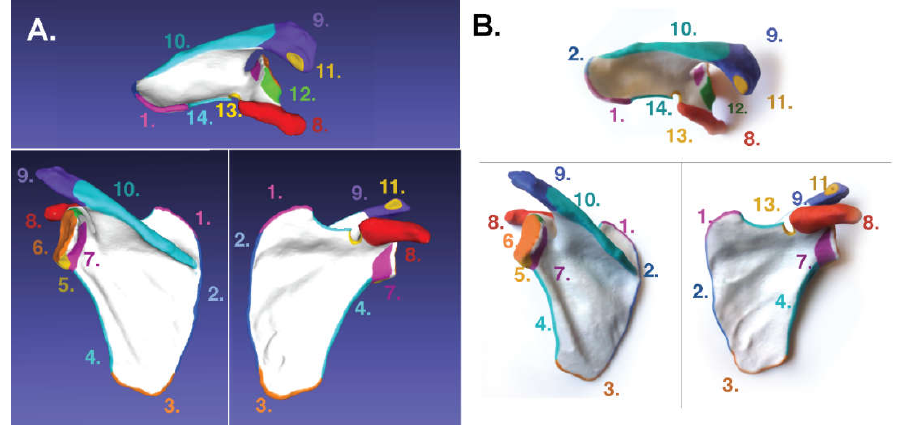
Figure 5. Panel A: Digital colored model. Panel B: resulting binder‐jet printed scapula including 1. superior angle, 2. medial margin, 3. inferior angle, 4. lateral margin, 5. infraglenoid tubercle, 6. glenoid cavity, 7. neck of scapula, 8. coracoid process, 9. spine of scapula, 10. acromion, 11. acromial articular surface, 12. supraglenoid tubercle, 13. scapular notch, and 14. superior margin. In each panel, top shows the superior view, left shows the dorsal view, and right shows the ventral view of scapula.